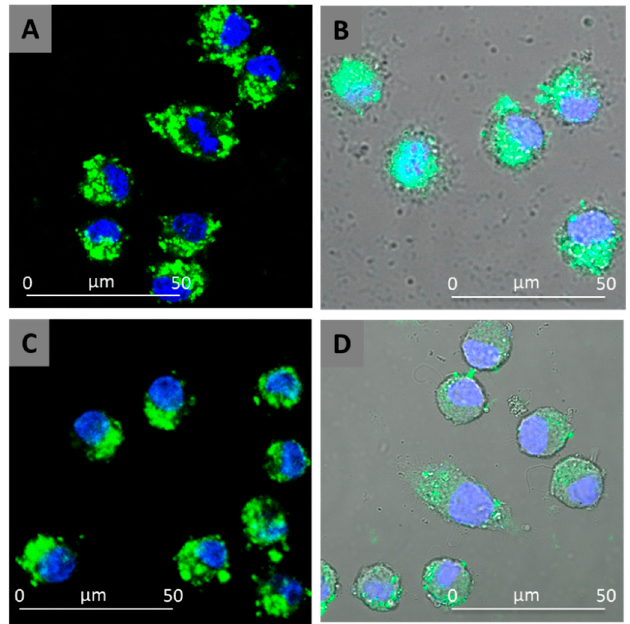
Figure 8. Confocal images of the macrophage uptake of NCs ( a ) and SUVs ( c ). Following nuclear staining with DAPI and FITC encapsulation into NCs and SUVs, the cell nuclei appear in blue and the NCs/SUVs appear in green. The confocal images are also superimposed to Bright Field acquisition ( b , d for NCs and SUVs, respectively) to show the unaltered morphology of the cells and the localisation of intracellular nanocarriers.